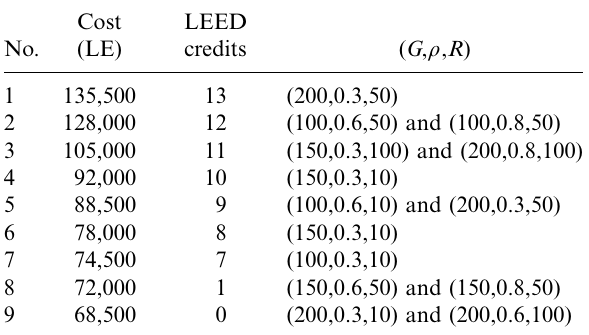
Table 4. Optimum solutions